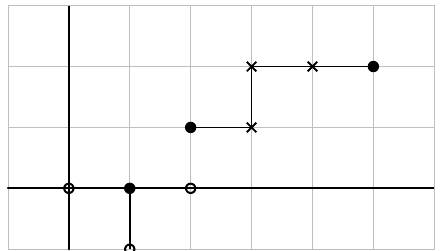
Figure 9. Generating function of the exponential factor in the realization of the fundamental representation in the (cid:12)rst direction at level